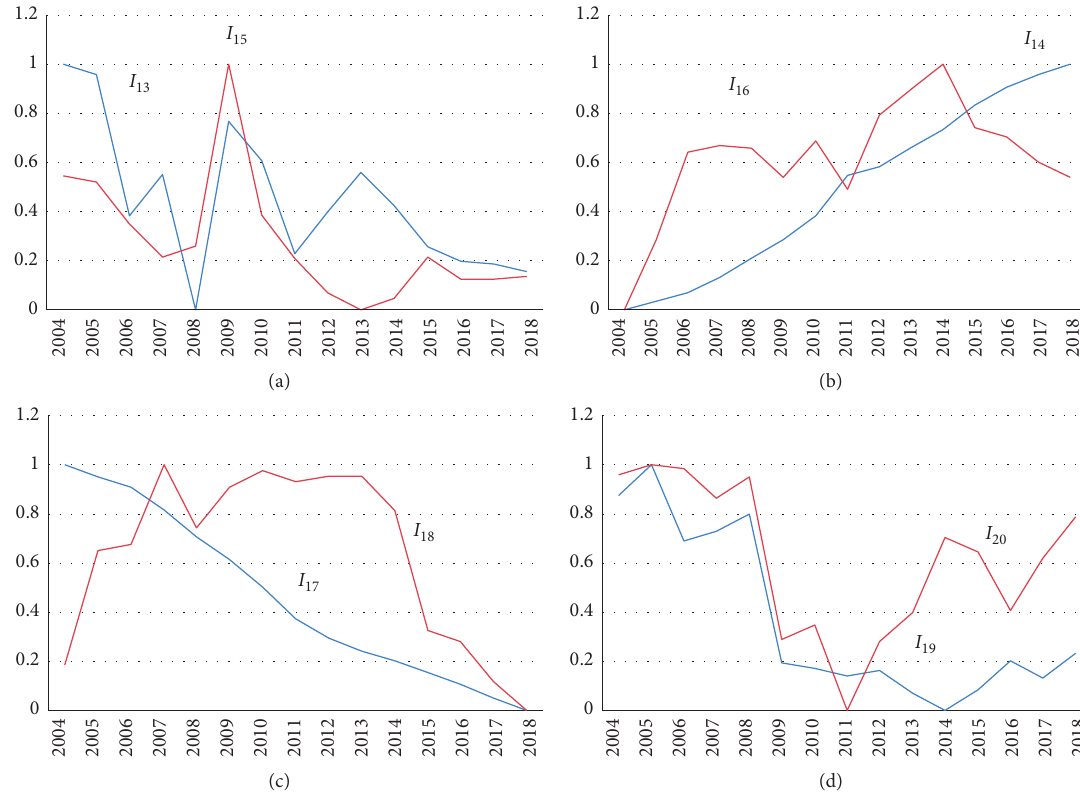
Figure 7: Dynamics of socioeconomic factors (normalized Table 1: Correlation matrix of factors I